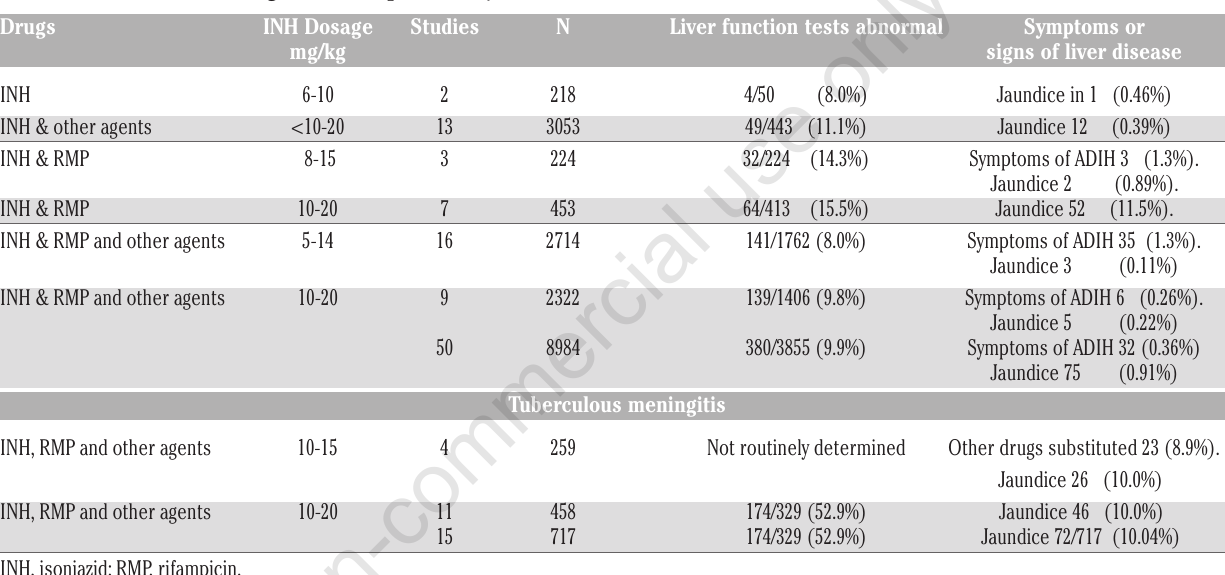
Table 3. Antituberculosis drug-induced hepatotoxicity in children treated for tuberculosis.